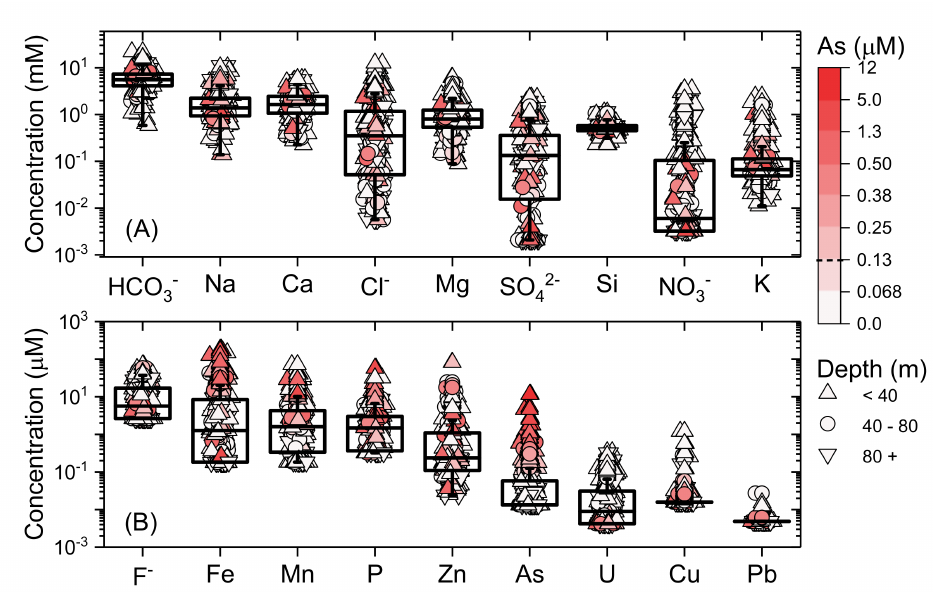
Figure 2. Box and Whisker diagram for ( A ) majors and ( B ) traces across Bihar. Boxes represent the 25–75% distribution (central line within box represents the median), and lines indicating the 5% and 95% intervals. Colour scale indicates As concentrations, and symbol shape indicates reported depth. Samples with measured concentrations below detection for a particular analyte were calculated based on maximum concentration at method detection limit for inclusion in box plots; where median or lower whiskers are not clearly seen there are high numbers of samples below detection.